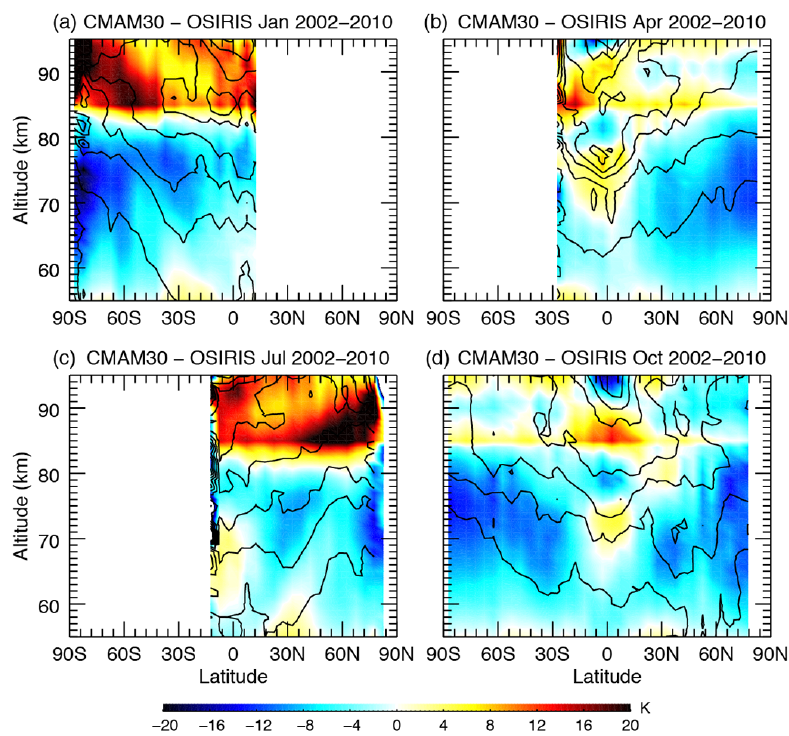
Figure 1. Absolute temperature differences for CMAM30 vs. OSIRIS profiles, derived from the O 2 A-band. Shown are averages over the entire time period for January (a) , April (b) , July (c) and October (d) . The median temperature difference is shown by the colour scale and the contours indicate the MAD with contour intervals of 2K. Reds indicate where CMAM30 has a warm bias compared with observations, and blues indicate where CMAM30 has a cold